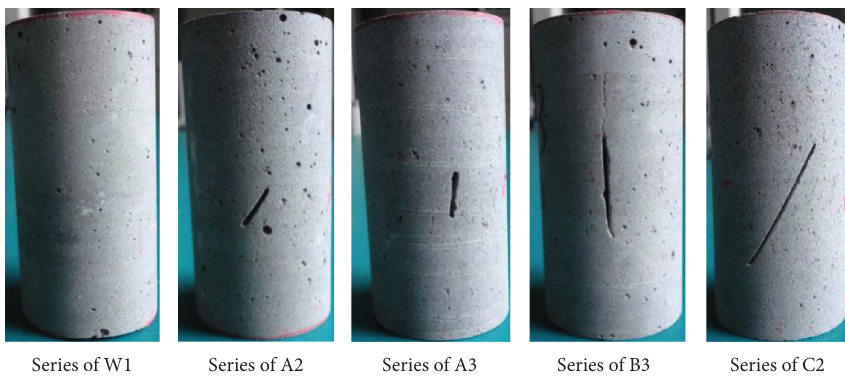
Figure 1: Intact specimen and single-fractured specimen. Table 1: Physicomechanical properties of the specimen and prototype.